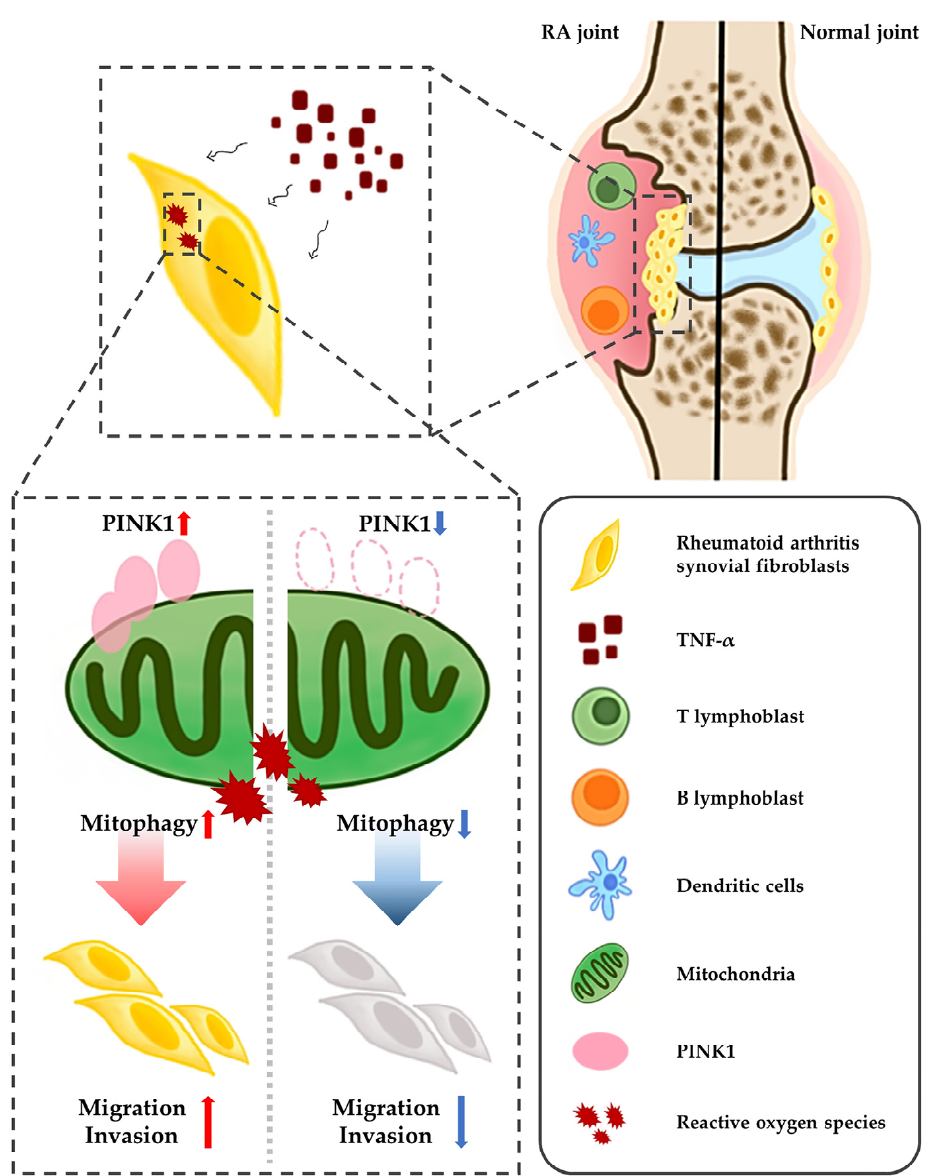
Figure 5. The role of PINK1 , mitophagy and TNF- α crosstalk in pathogenesis of RA. TNF- α -mediated RASFs proliferation, through the activation of mitophagy, destroys the synovial membrane and cartilage of CAIA mouse model. PINK1 -deficient RASFs accumulate damaged mitochondria as mitophagy is inhibited, preventing migration and invasion.